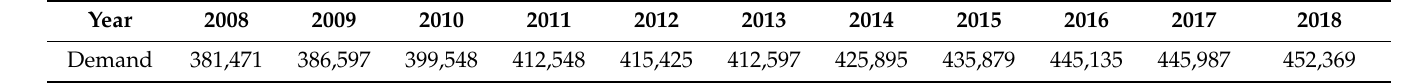
Table 3. Energy demand (in megawatts) of the area from 2008 to 2018.